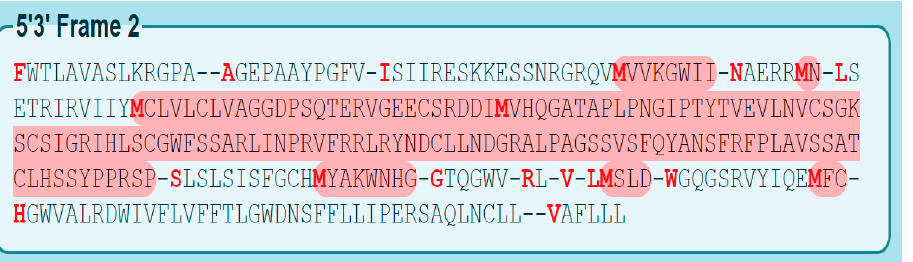
Figure 7. Translated protein sequence of TPD 1-like gene containing 132 amino acids (highlighted). Figure 6. The coding sequence of TPD1-like gene (XM_026801684.1) is highlighted.